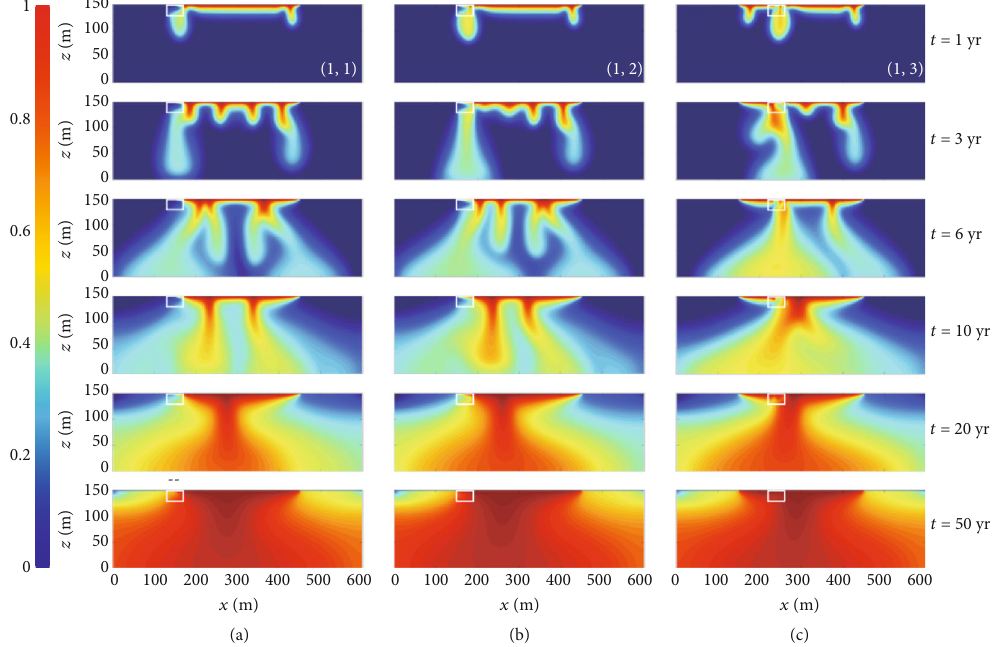
Figure 4: Concentration distributions in the domain with the high-permeability region ( k di ff erent times. The high-permeability regions are marked by the white rectangles.